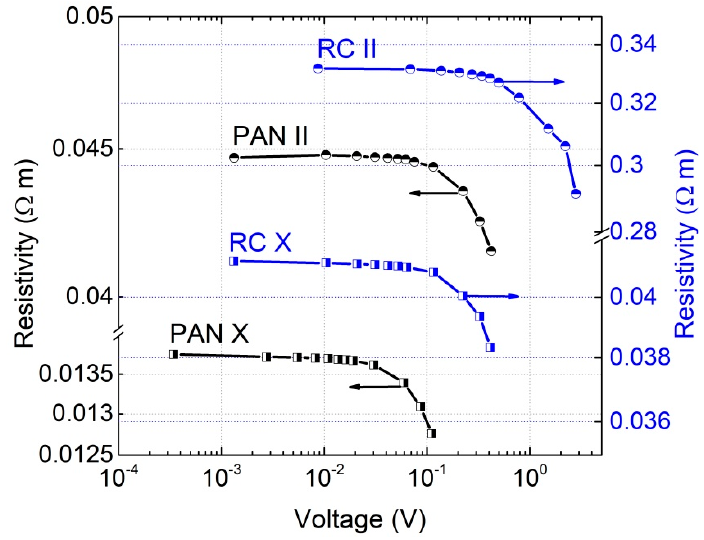
Figure 2. Resistivity dependence of the investigated composites with respect to room temperature voltage.